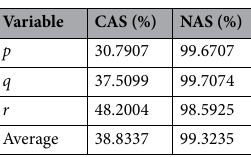
Table 4. The fitness of rotational states of UAV with 10% of τ .